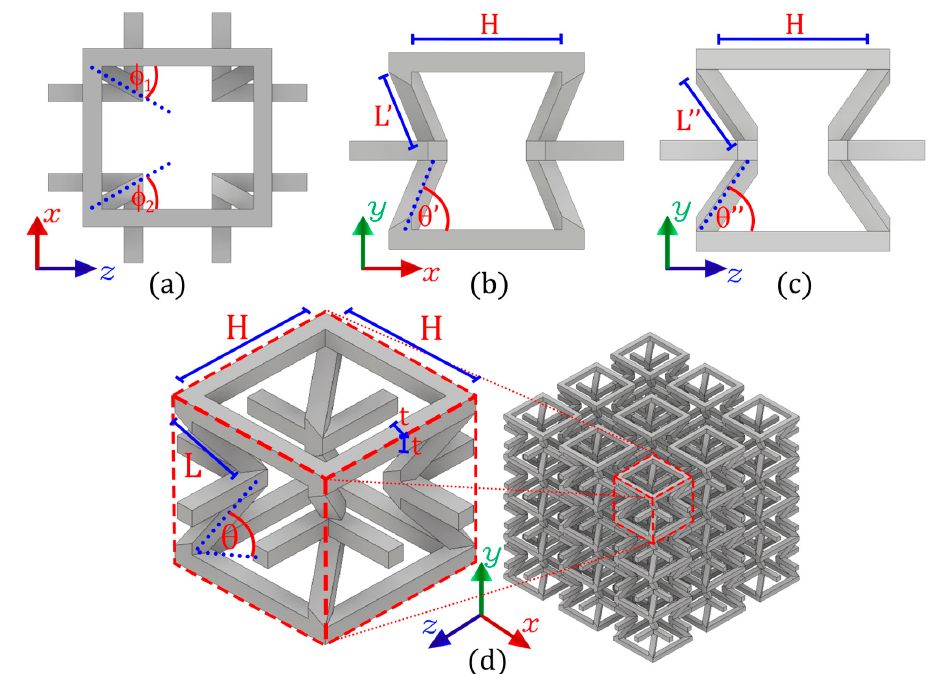
Figure 1. Auxetic structure design with re-entrant elements oriented under an angle of rotation ∅ ( a ). This modification in the topology produces two different transverse compression planes: ( b ) and ( c ). This unit cell can be modeled into a macrostructure, ensuring connectivity between cells ( d ). As is known, the deformation of auxetic structures with re ‐ entrant struts is produced by the elastic bending of their struts. Therefore, it is possible to model its mechanical be ‐ havior through the classical Timoshenko beam theory [33,38,49,53], according to the de ‐ composition shown in Figure 2. However, it has been shown in previous works [64,65] that Timoshenko ʹ s simplified analysis successfully predicts the mechanical behavior of an auxetic structure with an asymmetric design. Therefore, neither the shear strain ∆𝑦 nor the axial strain of the horizontal elements ∆𝑥 (cid:3010) and ∆𝑧 (cid:3010) will be considered for this analy ‐ sis since they are considered negligible.